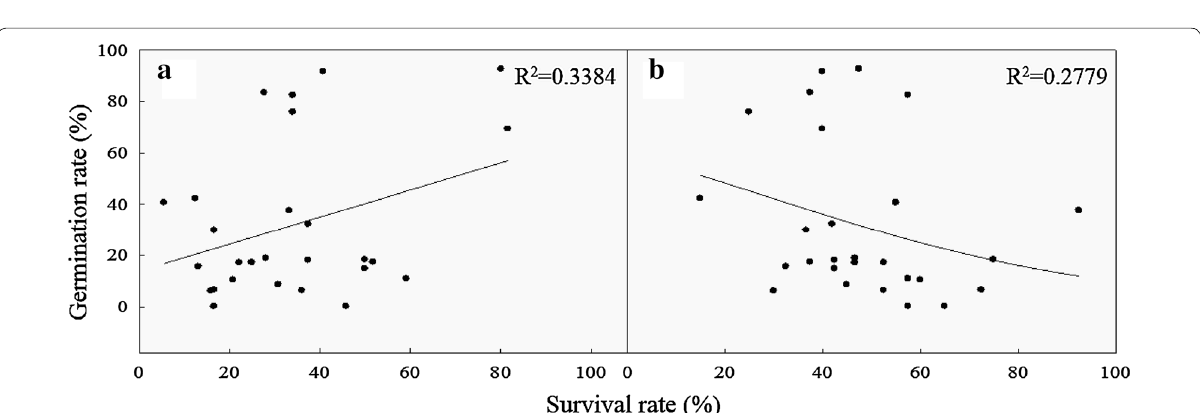
Fig. 4 Correlation between survival and relative germination rates under the HT45 ( a ) and TIR50 ( b ) treatments. Dots in the figure indicate varieties tested in this study and there are 27